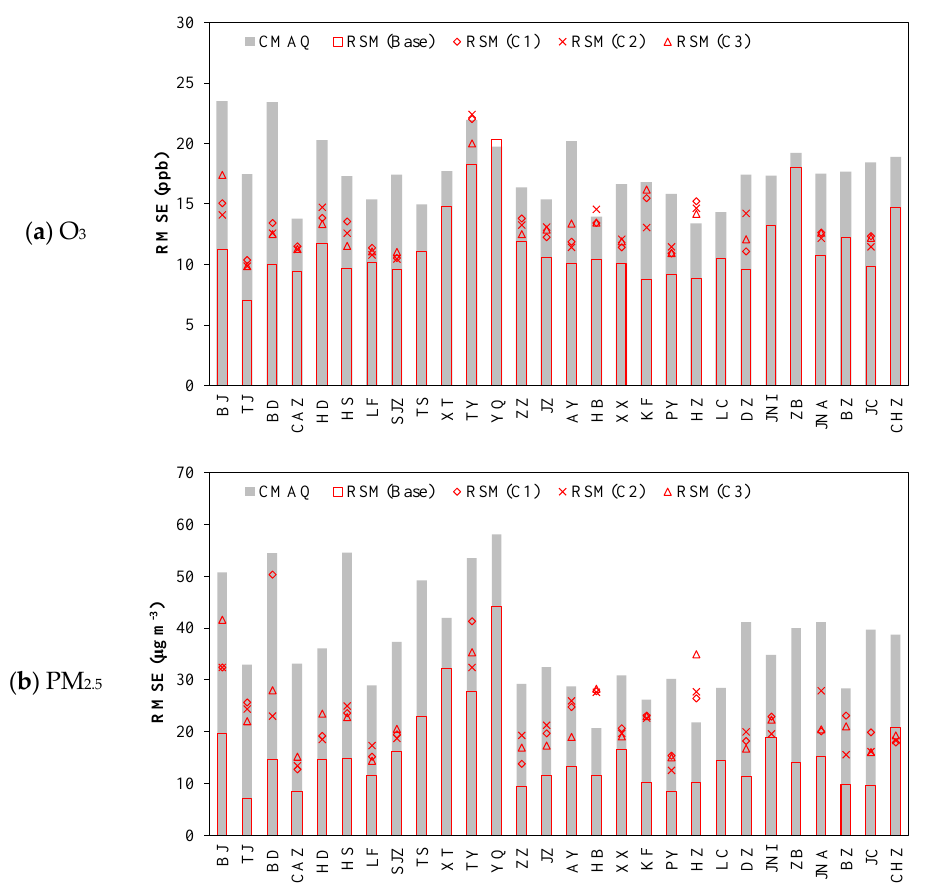
Figure 6. The performance of RSM-assimilation for O 3 ( a ) and PM 2.5 ( b ) by using a different number of observation sites.